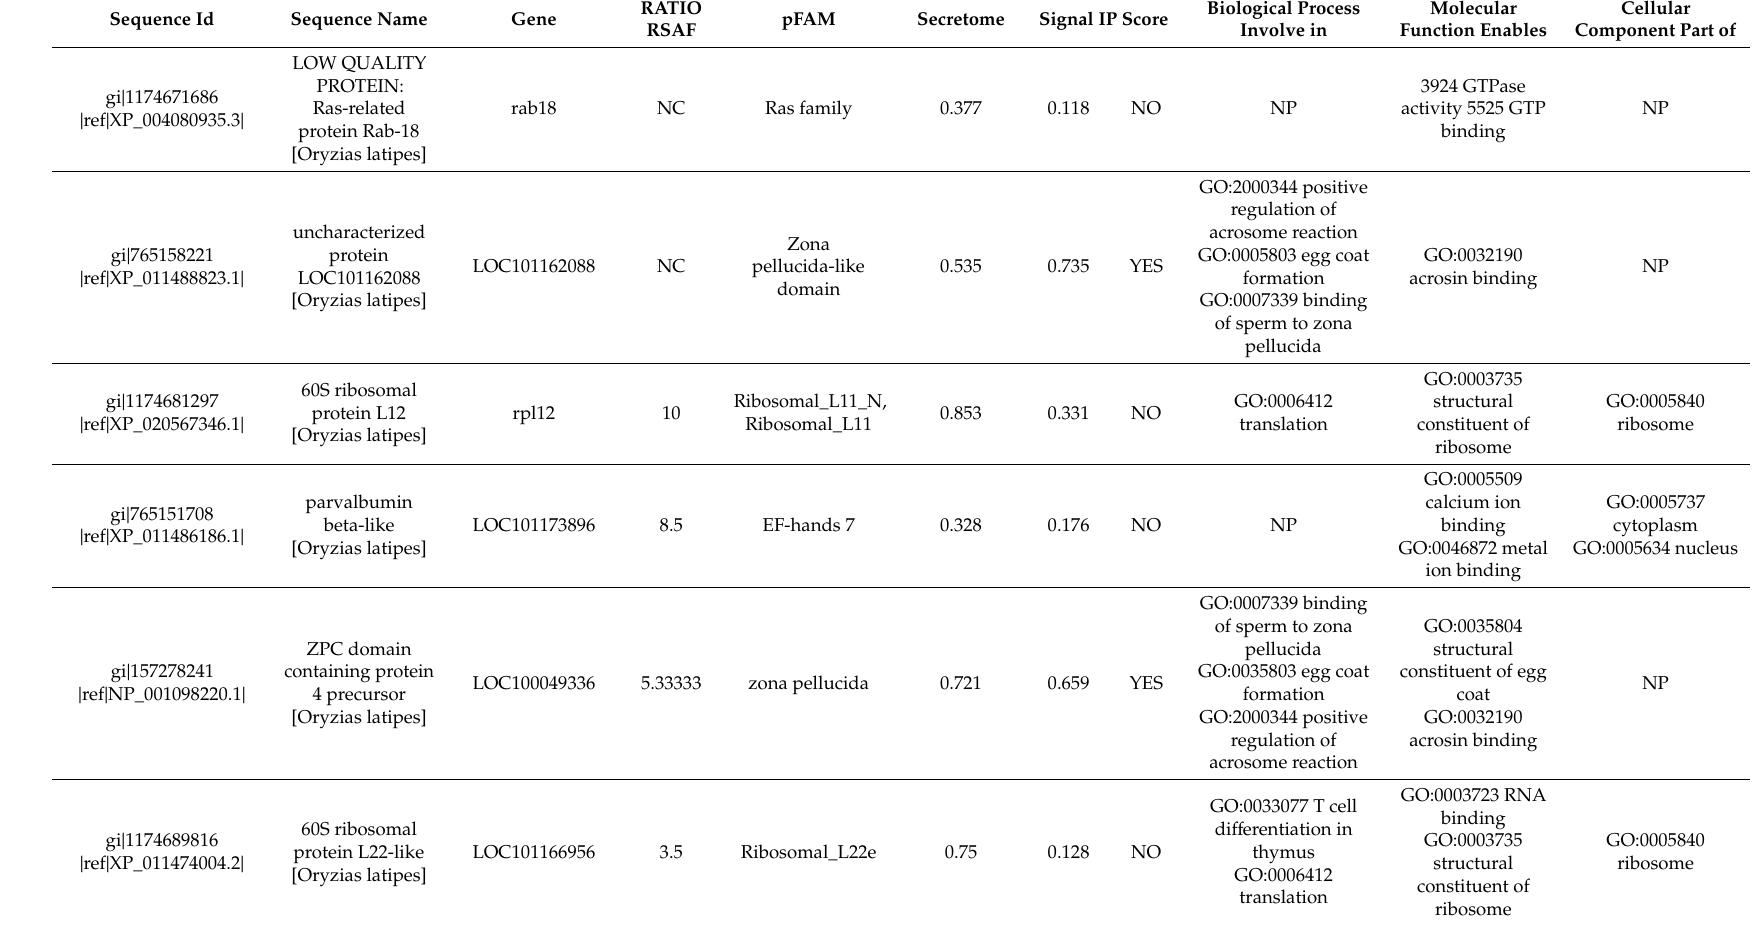
Table 2. Biological information of some overexpressed proteins detected in Medaka organs after acute exposure to